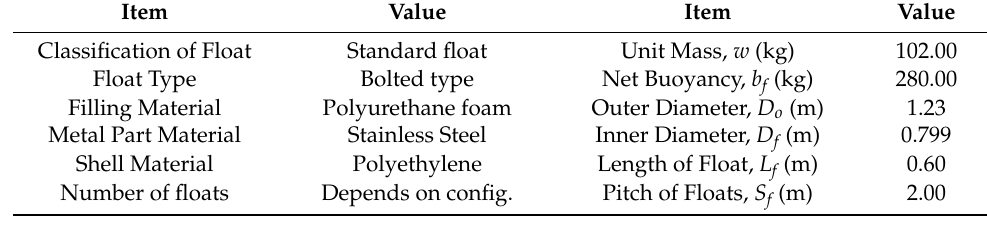
Table 5. Parameters for the buoyancy floats.